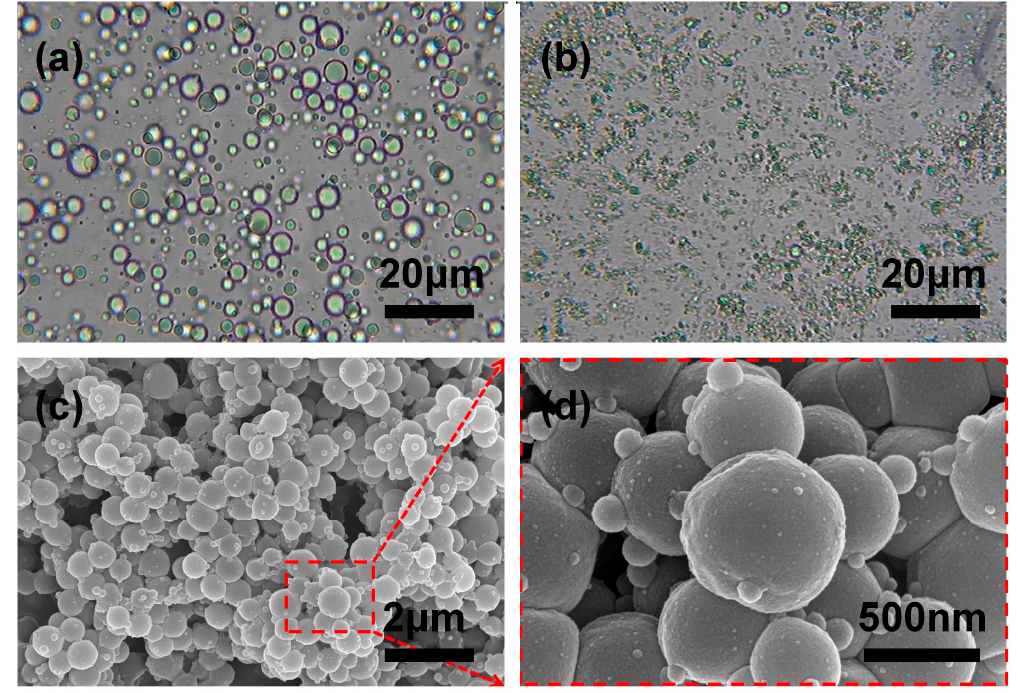
Figure 7. OM images of ( a ) O/W emulsion and ( b ) the growth process of MF shell encapsulating PAE core; SEM micrographs of ( c , d ) microencapsulated PAE with different magni fi cation.